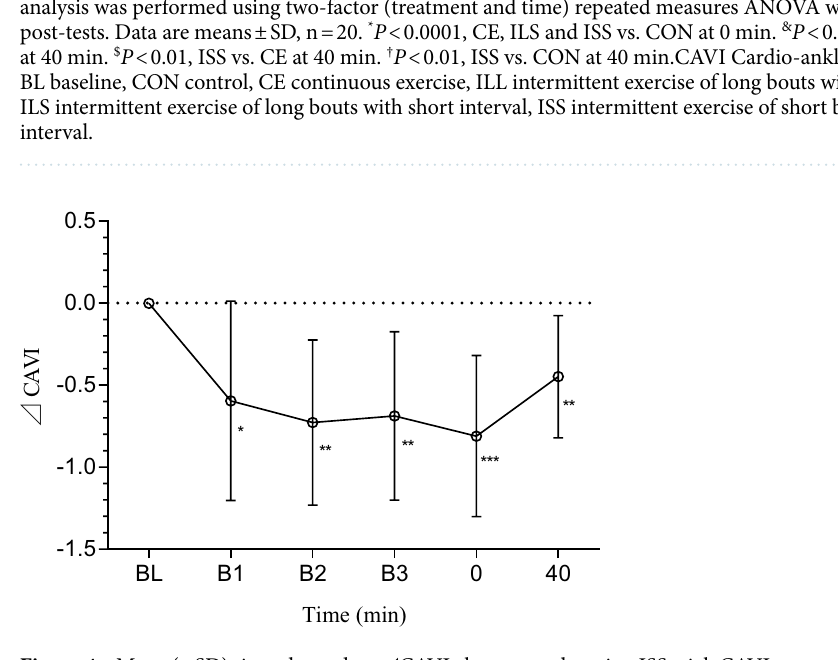
Figure 4. Mean (± SD) time-dependent ⊿ CAVI changes undergoing ISS trial. CAVI was measured at baseline, immediately before the second (B1), third (B2) and fourth bout (B3) respectively, and immediately after exercise (0 min), and 40 min after exercise (Fig. 1). Statistical analysis was performed using one-way ANOVA with repeated measures with Bonferroni post-tests. Data are means ± SD, n = 13. * P < 0.05 vs. BL; ** P < 0.01 vs. BL; *** P < 0.001 vs. BL. CAVI Cardio-ankle vascular index, BL